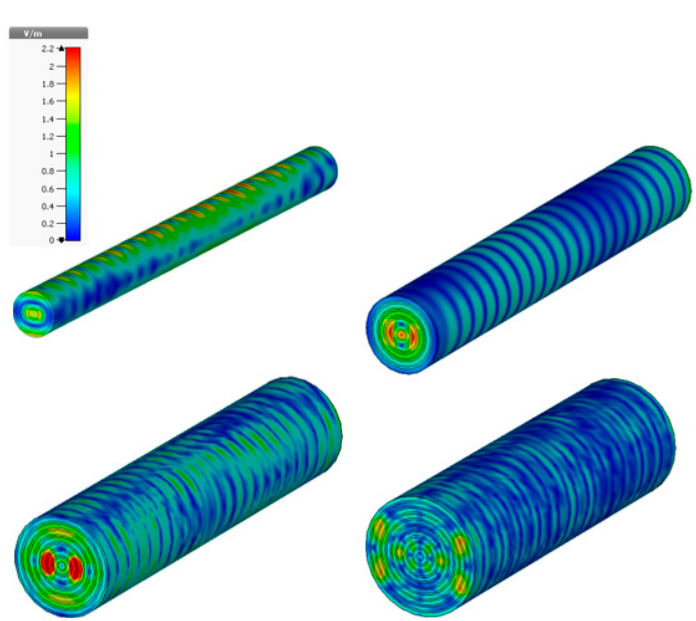
Figure 12. Electric field distribution inside wet poplar wood with different values of the number of growth rings with 100% permittivity variation at 3 GHz. Dielectric constant values were used with 28% moisture content according to [27].